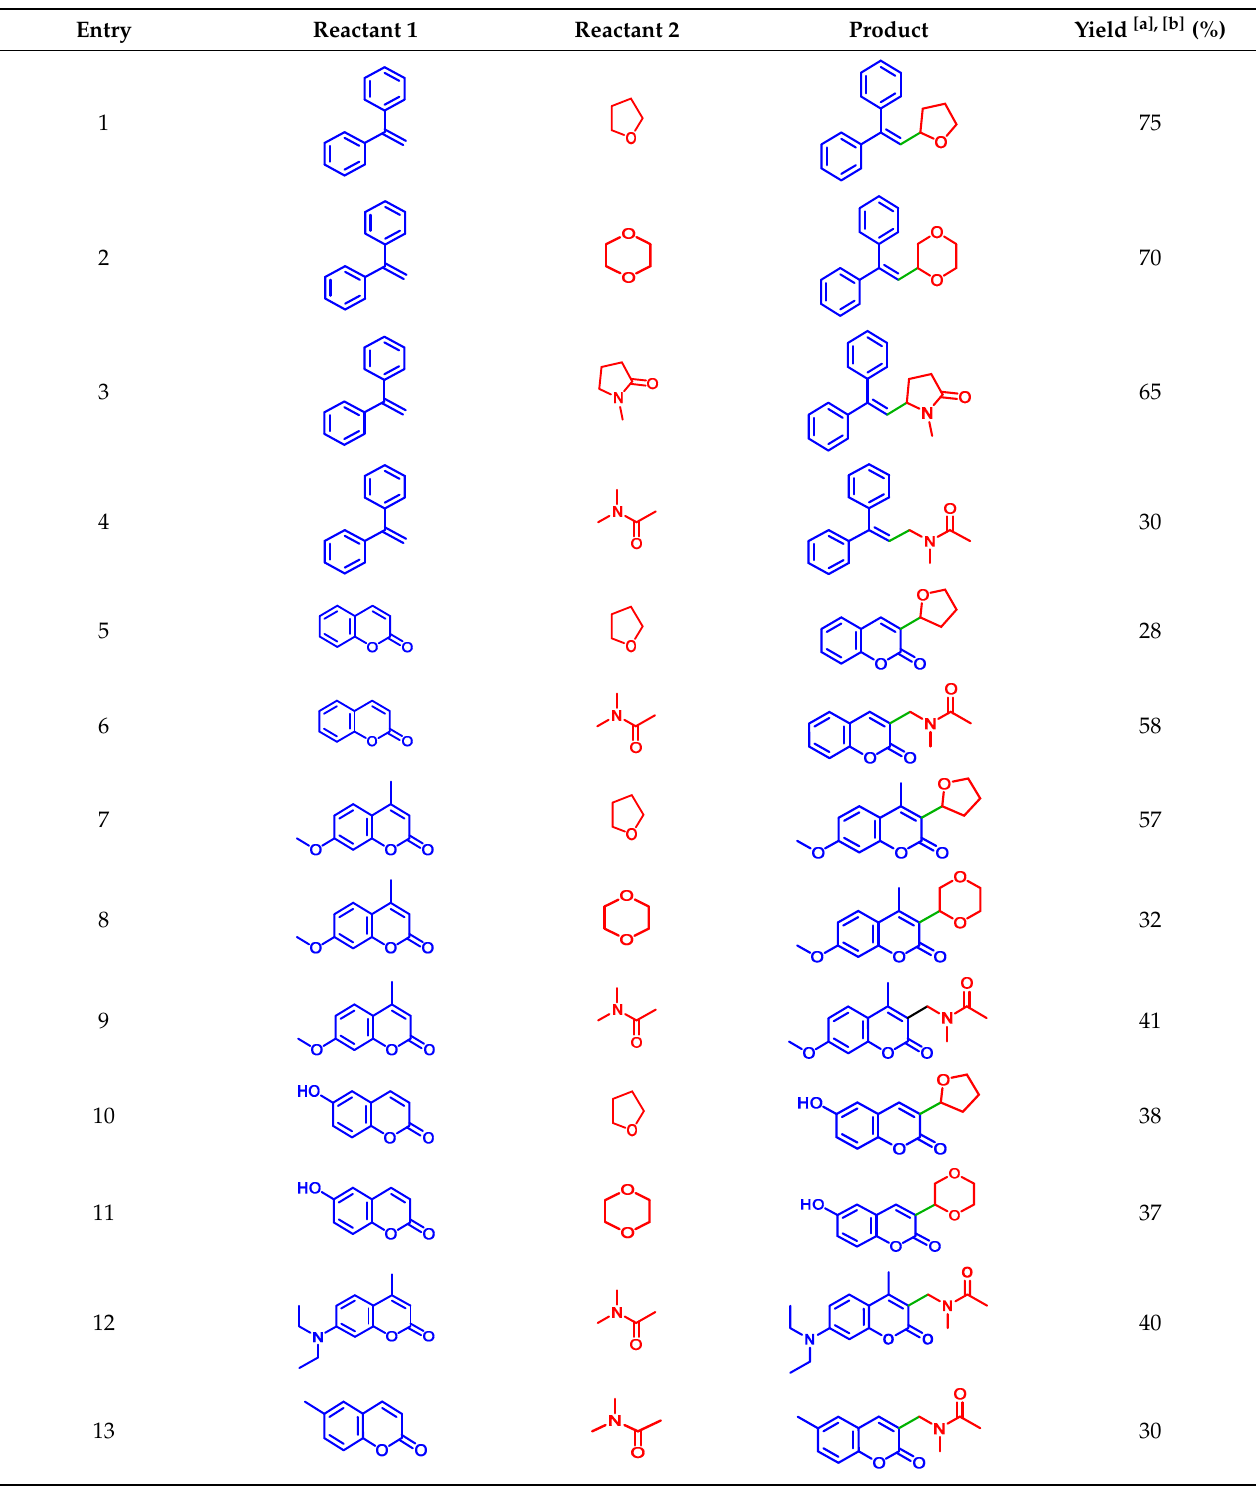
Figure 15. Recyclability test for the Cu 1 Ce 0.7 Si catalyst. 2.2.4. Dehydrogenative Coupling of Different Substrates The study scope was subsequently expanded to the cross-dehydrogenative coupling reaction between different reactants using the composite catalyst (Table 4). The reaction was conducted at 120 °C for 25 h using 4.8 mol% of Cu 1 Ce 0.7 Si with 4 equiv. of DTBP and 20 mol% of KI. The coupling products were then isolated by column chromatography. Table 4. Dehydrogenative alkenylation of C(sp 3 )-H adjacent to heteroatom catalyzed by the Cu 1 Ce 0.7 Si composite.